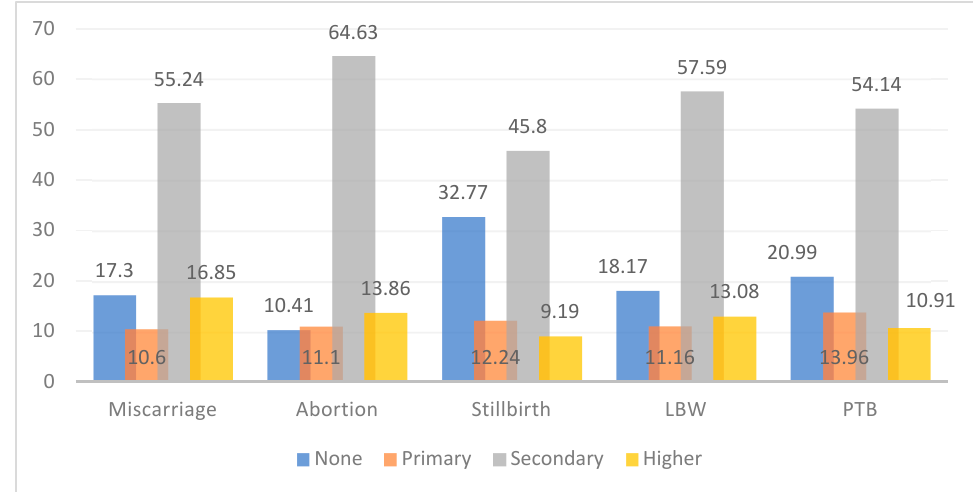
Figure 4. Percentage of women in each adverse birth outcome category, classified by their educational attainment levels. Source: Authors’ calculations.